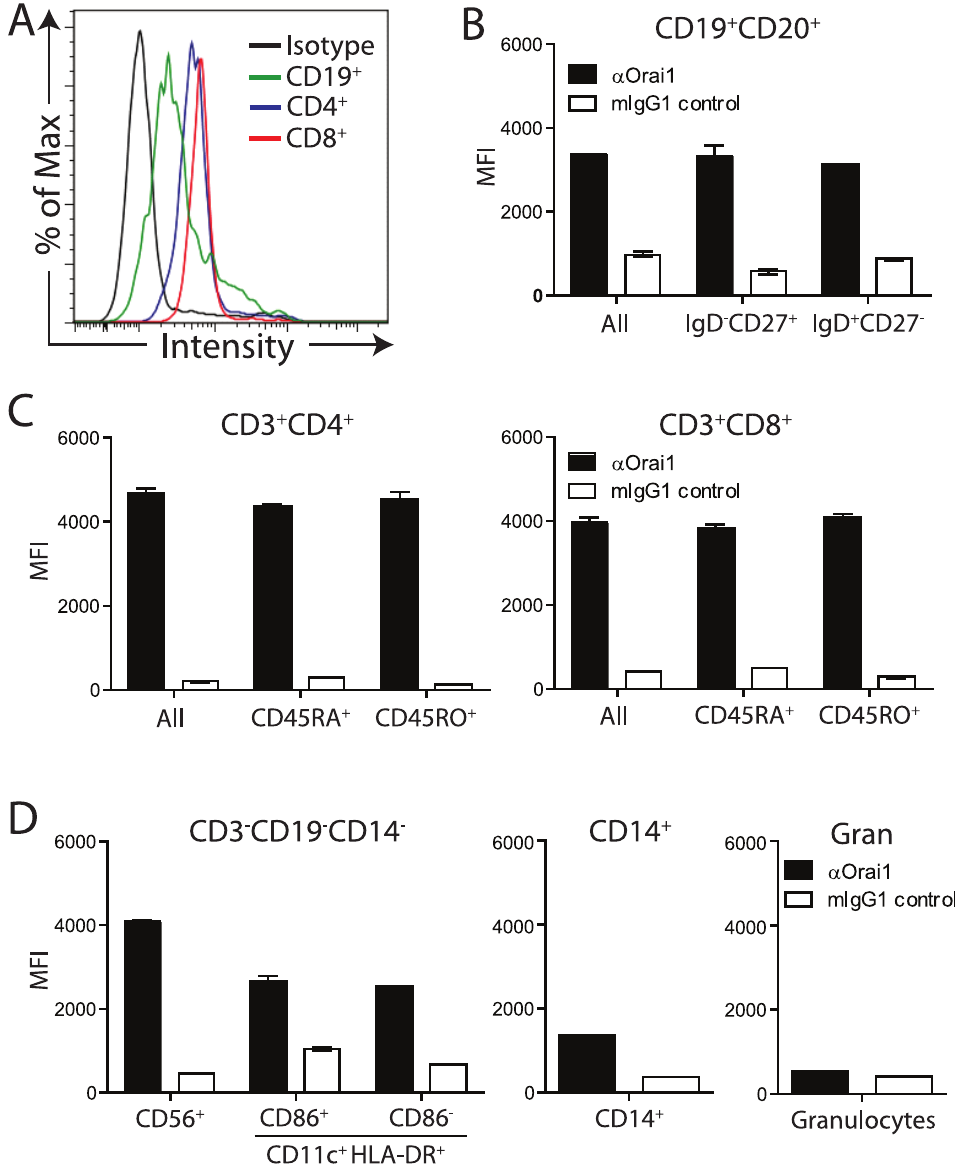
Figure 2. Anti-Orai1 antibody binds to native Orai1 on primary immune cells. A ) Representative histogram demonstrating a Orai1 or isotype control binding to primary immune cells (CD3 + CD4 + , CD3 + CD8 + , and CD19 + ) from the peripheral blood of a healthy individual using 12.5 m g/ mL antibody. B ) Median Fluorescence Intensity (MFI) of a Orai1 and mIgG1 control binding to memory (IgD 2 CD27 + ) and naı¨ve (IgD + CD27 2 ) CD19 + B cells; antibody used at 12.5 m g/mL. C ) Binding of a Orai1 and mIgG1 control to naı¨ve (CD45RA + ) and memory (CD45RO + ) CD3 + CD4 + and CD3 + CD8 + T cells. D ) Binding of aOrai1 to non-lymphocyte NK cells (CD3 2 CD19 2 CD14 2 CD56 + ), CD86 + and CD86 2 dendritic cells (CD3 2 CD19 2 CD14 2 CD11c + HLA- DR + ), CD14 + monocytes, and granulocytes. All data is representative of at least three independent